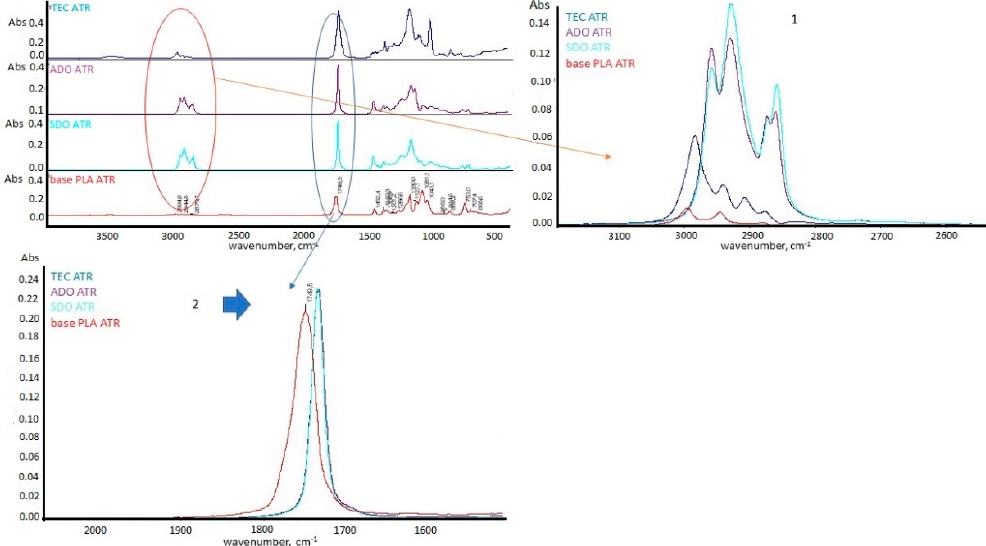
Figure 11. FTIR-ATR spectrum for the plasticizers.